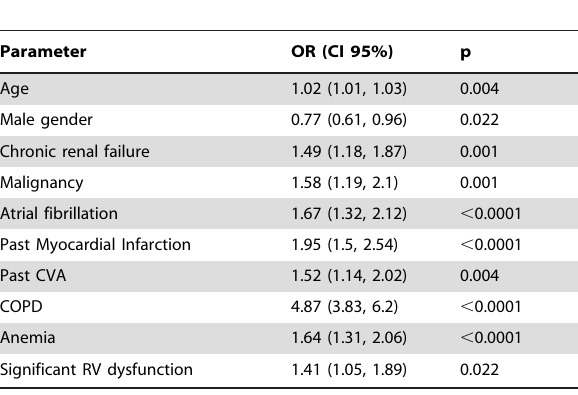
Table 2. Predictors for respiratory infection sepsis or